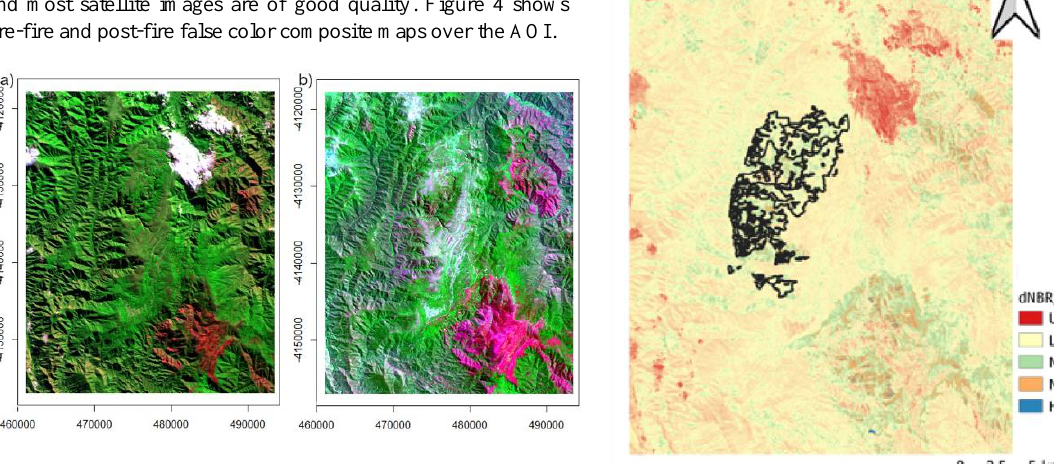
Figure 4. Landsat-8 pre-fire (a) and post-fire (b) images covering the area of bushfires, respectively. Band combination is R:G:B=7:5:2. Foreshowing changes before and after fire.